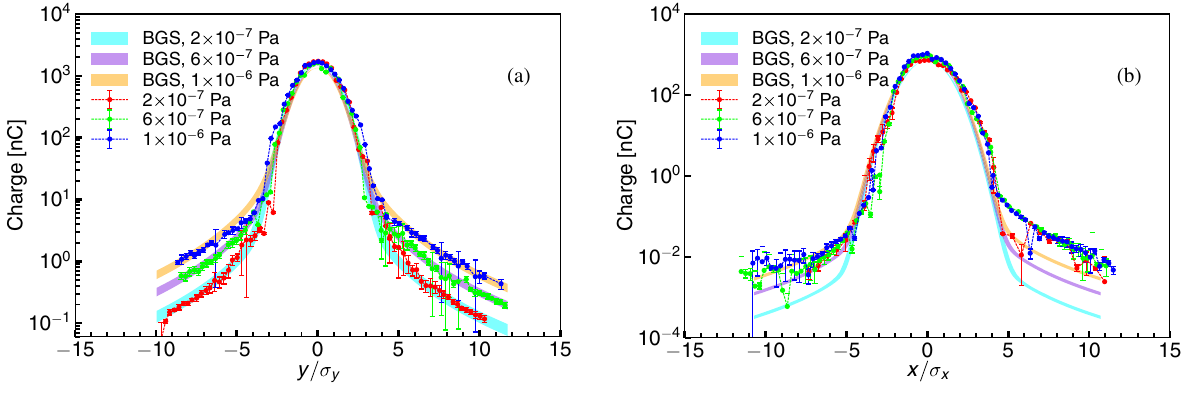
FIG. 9. Vertical (a) and horizontal (b) beam profiles normalized to beam core sizes for different vacuum pressures. The widths of the bands shown for the predictions from the BGS simulation represent the uncertainty of the beam size